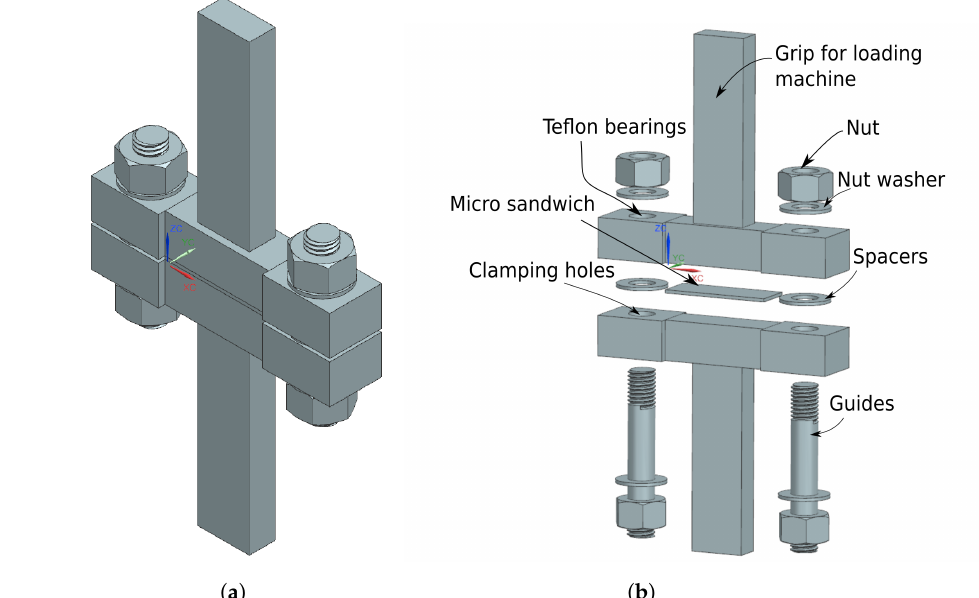
Figure 4. A perspective view of the test tool used for LC 1 is presented in ( a ). In ( b ), an exploded view of the test tool, with all constituents indicated, is